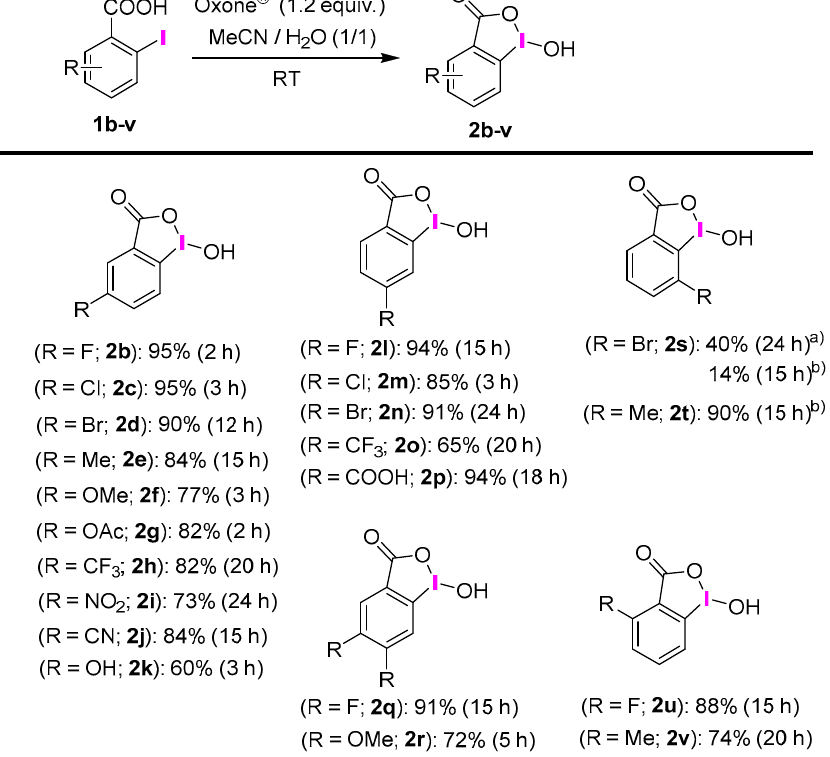
Figure 4. Substrate scope of the selective preparation of IBAs 2b – v using Oxone ® under aqueous conditions. a) This reaction was performed at 30 °C in the presence of 1.2 equivalents of Oxone ® . b) Performed using 5 equivalents of Oxone ® at 40 °C.